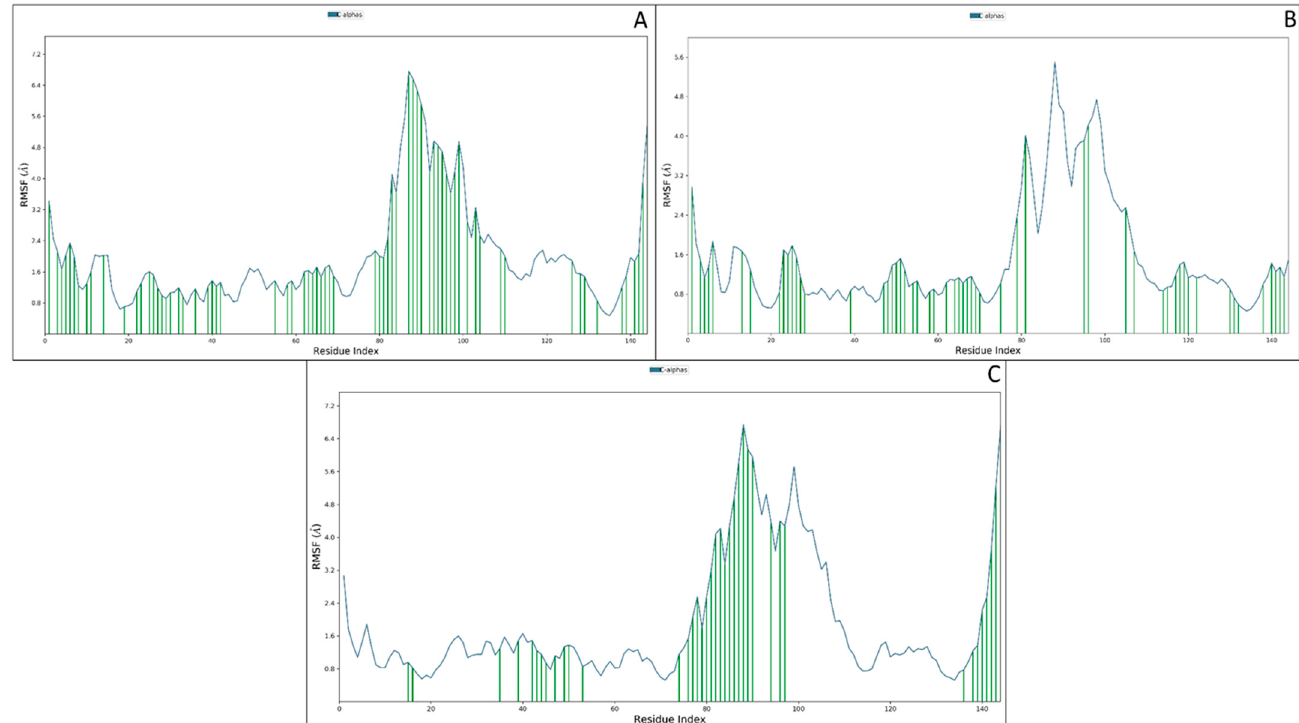
Figure 6. The root mean square fluctuations of the macrophage mannose receptor in the complex condition of ( A ) mannose, ( B ) PLGA, and ( C ) punicalagin. The blue line shows the amino acid level fluctuations, while the green vertical line shows the ligand contact with the amino acids at a particular simulation time.